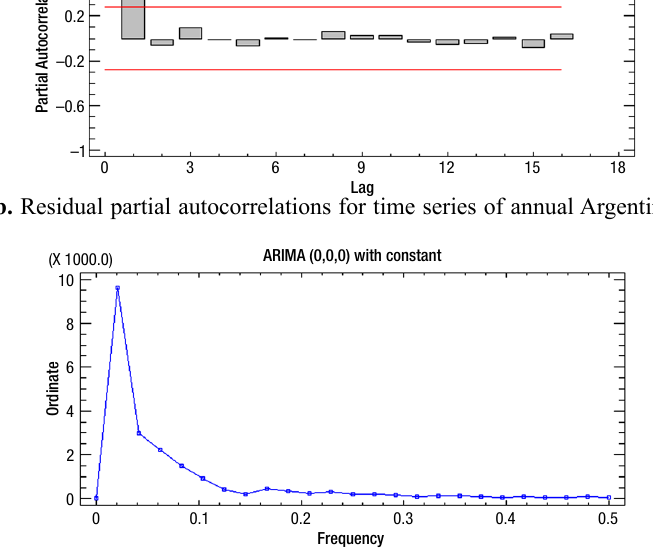
Fig. 14. Residual periodogram for time series of annual Argentinian GDP